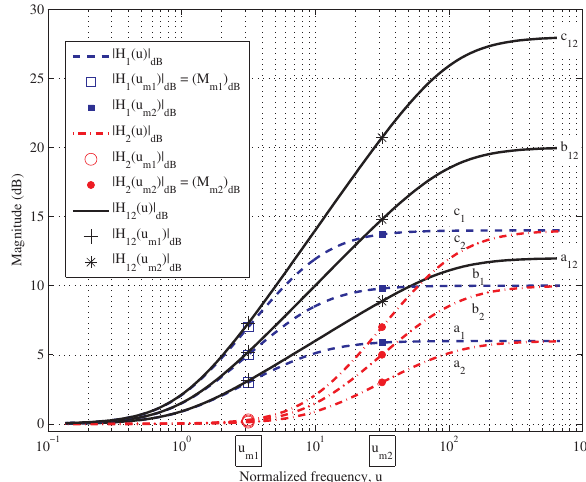
Figure 3. Bode magnitude diagrams of H 1 ( ju ) (dashed lines), H 2 ( ju ) (dash-dotted lines) and H 12 ( ju ) (solid lines) for ν = ν 1 = ν 2 = 0.3 (curves a 1 , a 2 and a 12 ), 0.5 (curves b 1 , b 2 and b 12 ), 0.7 (curves c 1 , c 2 and c 12 ).